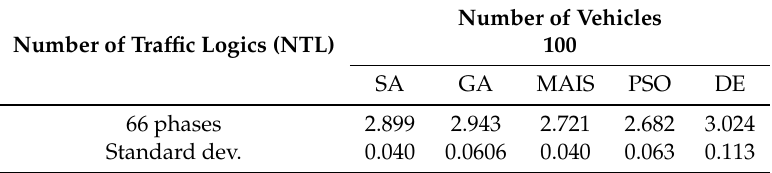
Table 3. Average fitness value obtained by the algorithms for the first experiment